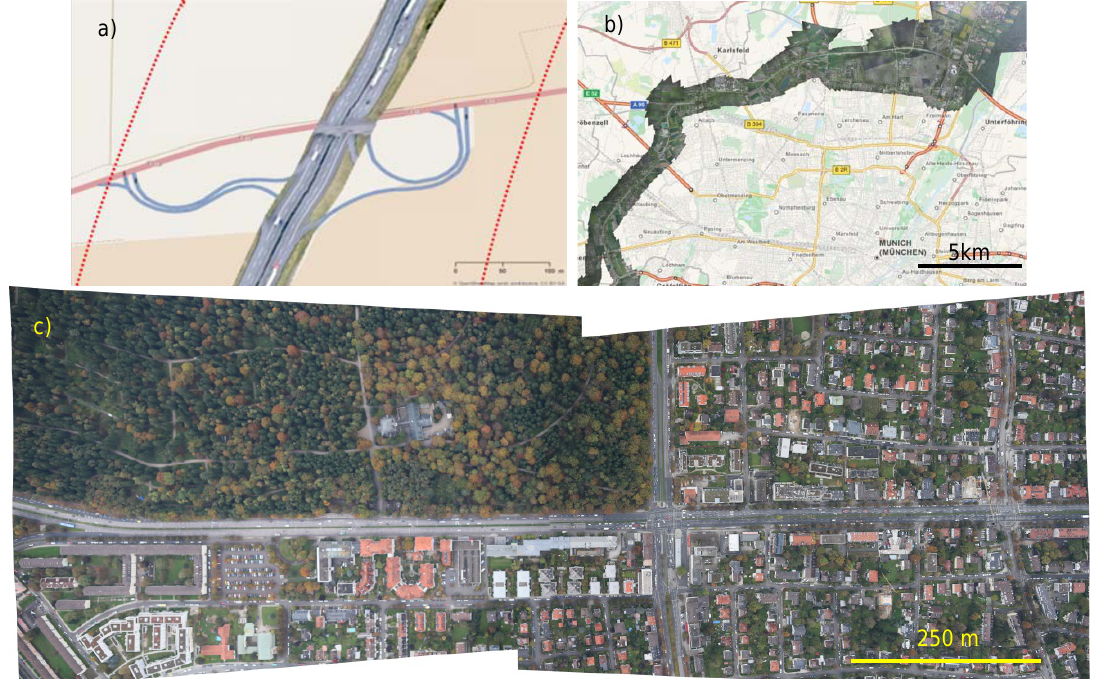
Figure 2: Map section from different sensors and platforms. a) Map section acquired with the FLIR Ultraforce II sensor system on 16 th January 2015 south of Darmstadt/Germany (flight height 350m a.g.). Red dotted lines show the coverage of the 4k sensor system from the same flight height; b) Map section acquired with the CHICAGO sensor system in the north of Munich/Germany on 19 th May 2012 (flight height 600m a.g.); c) Map section acquired with the 4k sensor system on 16 th October 2014 in Munich (flight height 1000m